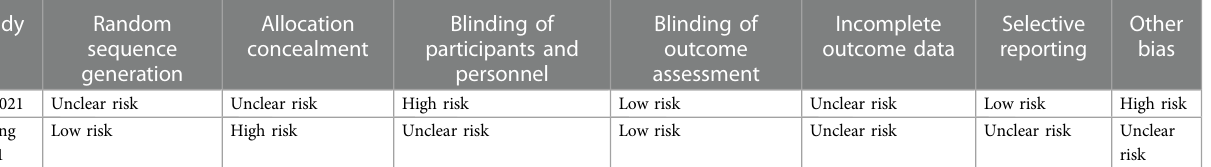
TABLE 1 Risk of bias assessment of the randomized controlled